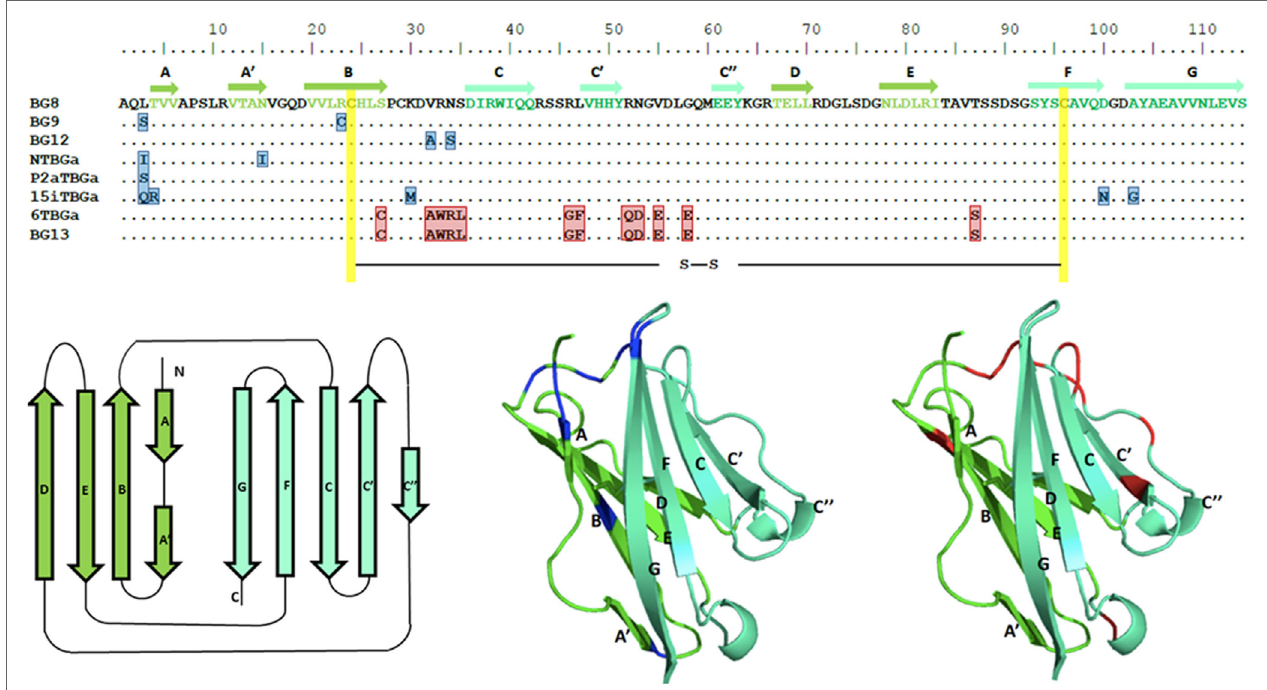
FigUre 7 | Alignment of amino acid sequences for the Ig-V domains of the dominantly expressed genes from four chicken lines identified in this paper, and for the appropriate genes of the B12 haplotype from Ref. (24), along with structural models of the Ig-V domains with the location of variation compared with the BG8 sequence of the B12 haplotype indicated. Names of the transcripts follow the convention: abbreviated line name, “T” for T cells, “BG” and the letter “a” representing the most frequently detected exon 2 sequence. Names of the genes follow the convention “BG” and the number of the gene locus from the B12 haplotype. In the top panel, letters indicate amino acids by single letter code, dots indicate identities with BG8 sequence, residues that differ from BG8 are boxed in blue for the three lines, and red for line 6 1 and BG13; yellow indicates the intra-domain cysteines. The β -strands of the V region are indicated by arrows in the top panel, and are colored dark green for one face of the domain and light green for the other face. The same color scheme is used for the three panels below, with the positions of residues for the three lines (and BG9 and BG12) that differ from BG8 colored blue in the middle panel, and positions of residues for line 6 1 and BG13 that differ from BG8 colored red in the right hand